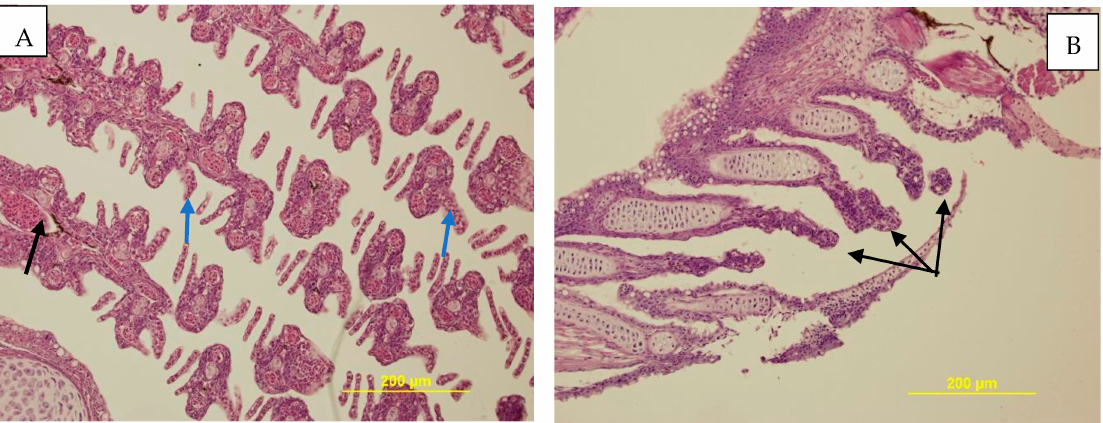
Figure 7. The gills at the control group ( A ); (black arrow vessel tinting, blue arrow leaf deformation), and gills at the concentration 1000 µg/L of PCZ ( B ); (black arrows showing total deformation of gill leaves).